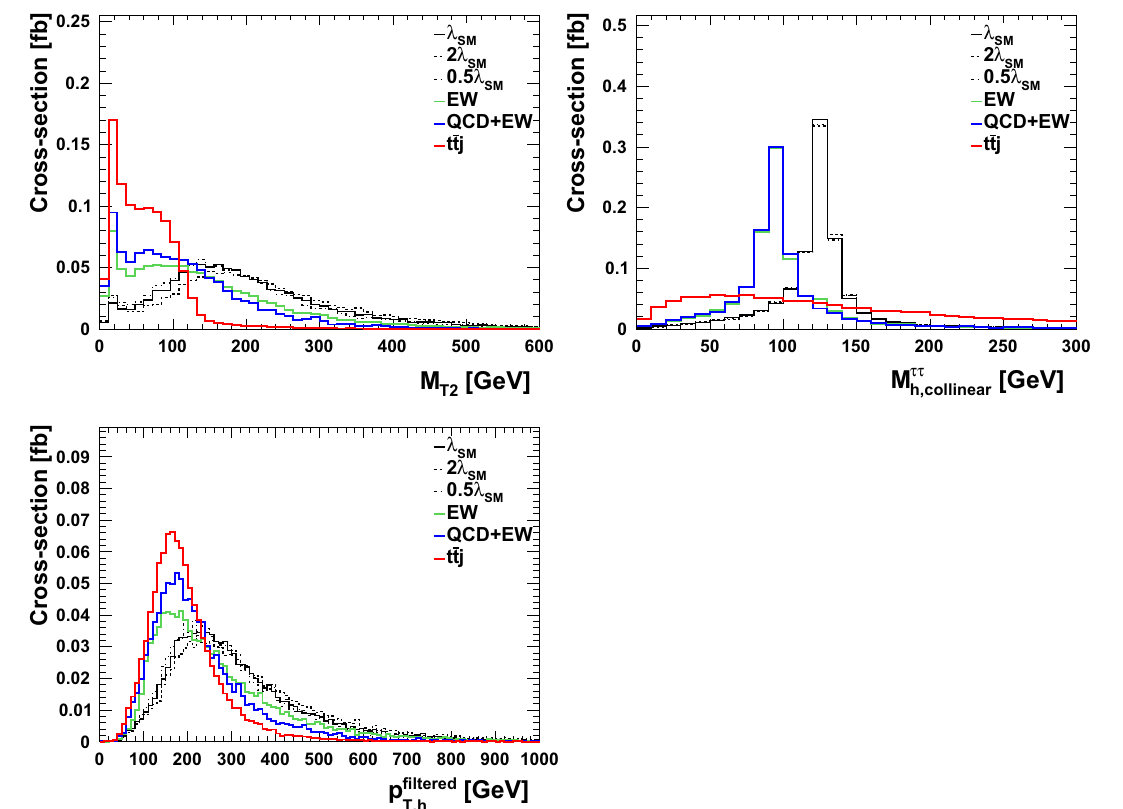
Fig. 5 Discriminating observables contributing to the boosted analysis of Sect. 2.4 Table 5 Results of the boosted pp → hhj decay channels outlined in Sect. 2.4 in femtobarns (numbers to the left of the double vertical lines) after an optimised cut on the BDT output. We include results for Signal Tot.